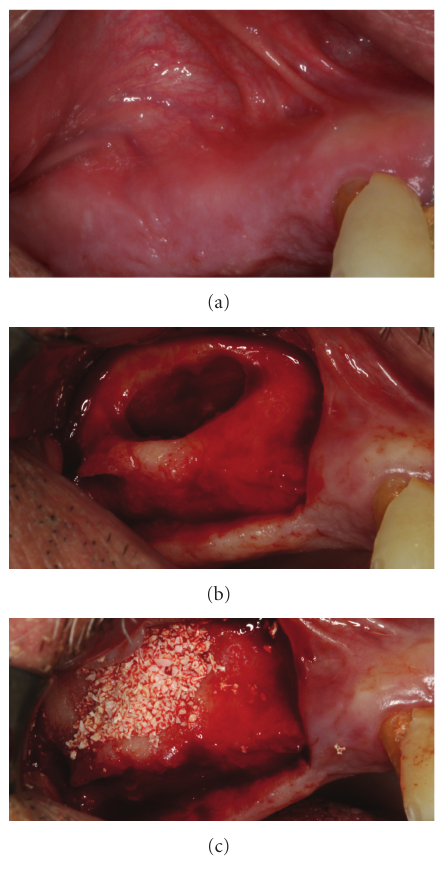
Figure 1: Site before exposure (a), direct exposure of lateral sinus wall (b), and filling of sinus with the selected grafting material